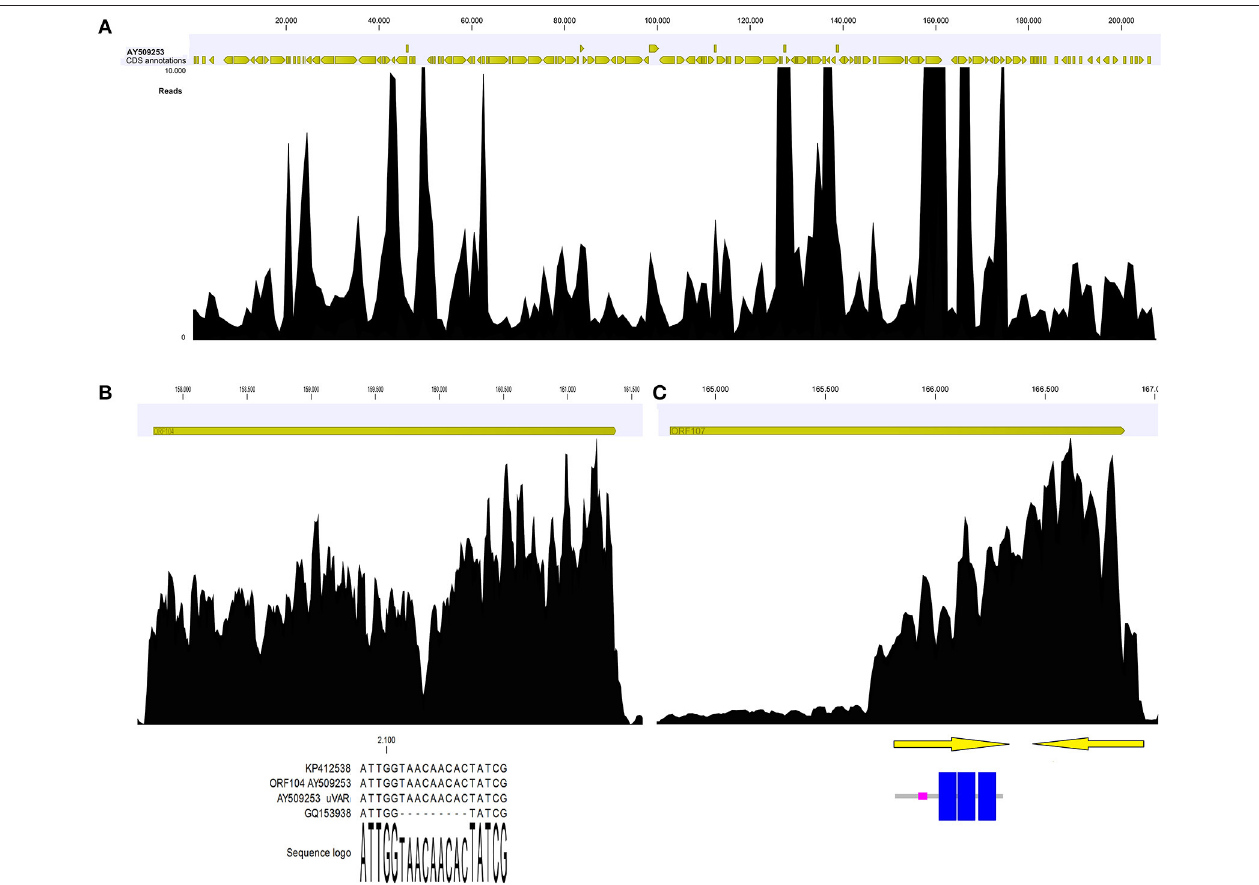
FIGURE 4 | Coverage graph of Malacoherpesviridae reads (A) . Coverage graph of the whole OsHV-1 genome, as obtained by mapping 4.9 M viral reads with length and similarity mapping parameters set to 0.9. Yellow arrowheads indicate annotated ORFs along the virus genome. Maximum coverage was set to 10,000x. (B) Details of the ORF104 coverage graph, with the alignment including the 9-nt deletion causing coverage drop-off. (C) Details of ORF107 coverage graph, with two nested ORFs (arrows) that could explain the local coverage bias. One ORF encoded three transmembrane regions (highlighted in blue).